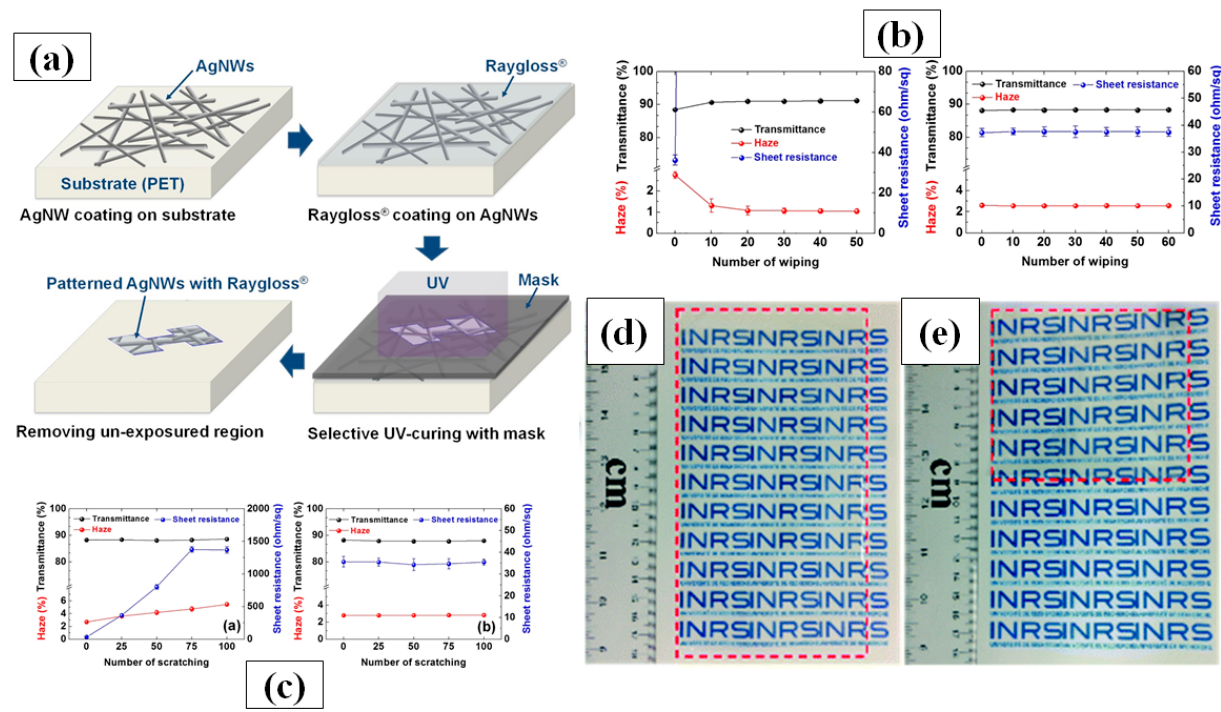
Figure 12. ( a ) Illustrations of the patterning process of Raygloss ® /Ag nanowire electrodes. ( b ) Change in optical transmittance, haze, and sheet resistance as a function of the number of scratches for the bare Ag nanowire electrodes and Raygloss ® /Ag nanowire electrodes, ( c ) The wiping test results of the bare Ag nanowire electrodes and Raygloss ® /Ag nanowire electrodes (adapted from [174] with permission from Elsevier, 2017). Photographs of a large-area (18 cm × 9 cm) and flexible Ag NW TCE ( d ) before and ( e ) after bending by 180 ◦ . Red dashed lines highlight the edges of the flexible Ag NW TCE (adapted from [176] with permission from Royal Society of Chemistry, 2020).